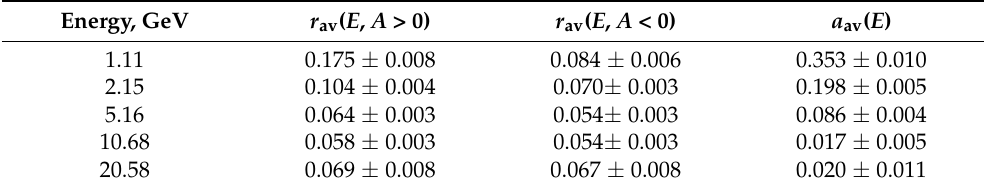
Table 1. The values of the ratio of positron to electron intensities as a function of energy in the positive and negative phases of the 22-year solar magnetic cycle (2011 – 2017) and the values of a av ( E ) (see text). Energy, GeV